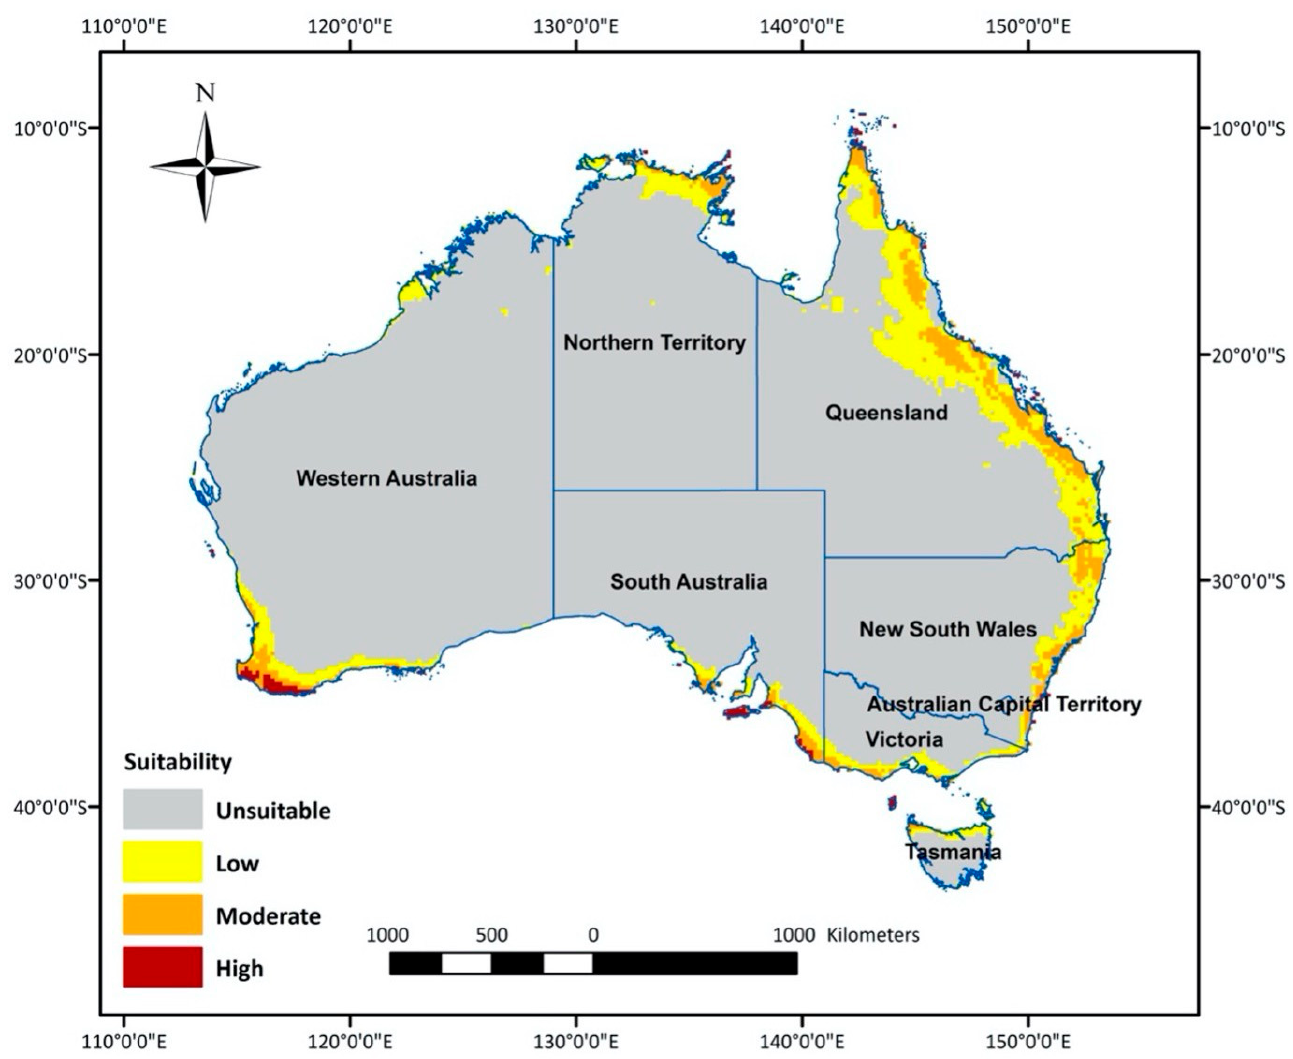
Figure 2. Areas in Australia with a climate suitable (high, medium, low or unsuitable) for Thauma- totibia leucotreta establishment. Table 2. Summary of potential establishment areas (ha) for Thaumatotibia leucotreta in each Australian